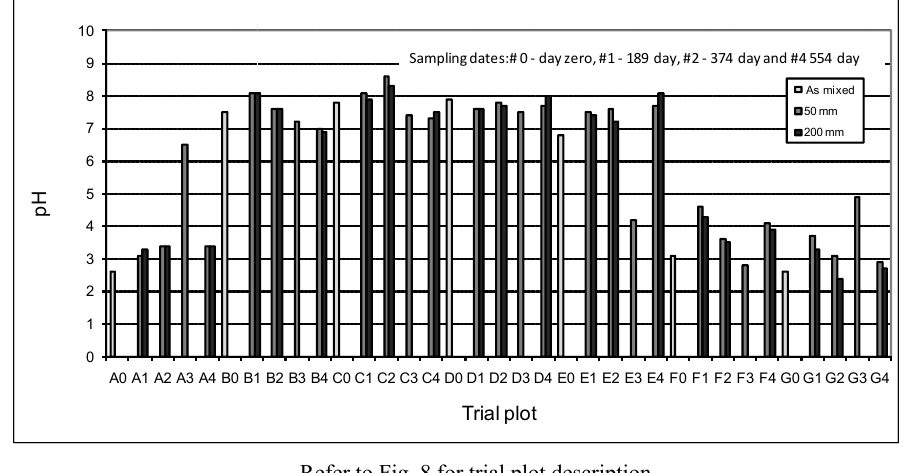
Refer to Fig. 8 for trial plot description Fig. 10. Variation of pH with time for Car Wood